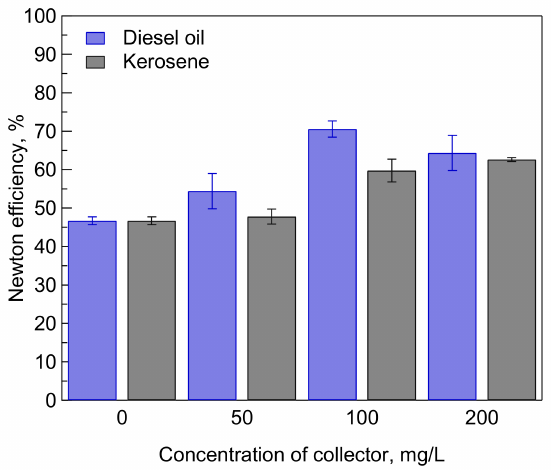
Figure 7. Effects of diesel oil and kerosene addition on the Newton efficiency of selective flotation of chalcopyrite and molybdenite in 1 mM MBS at pH